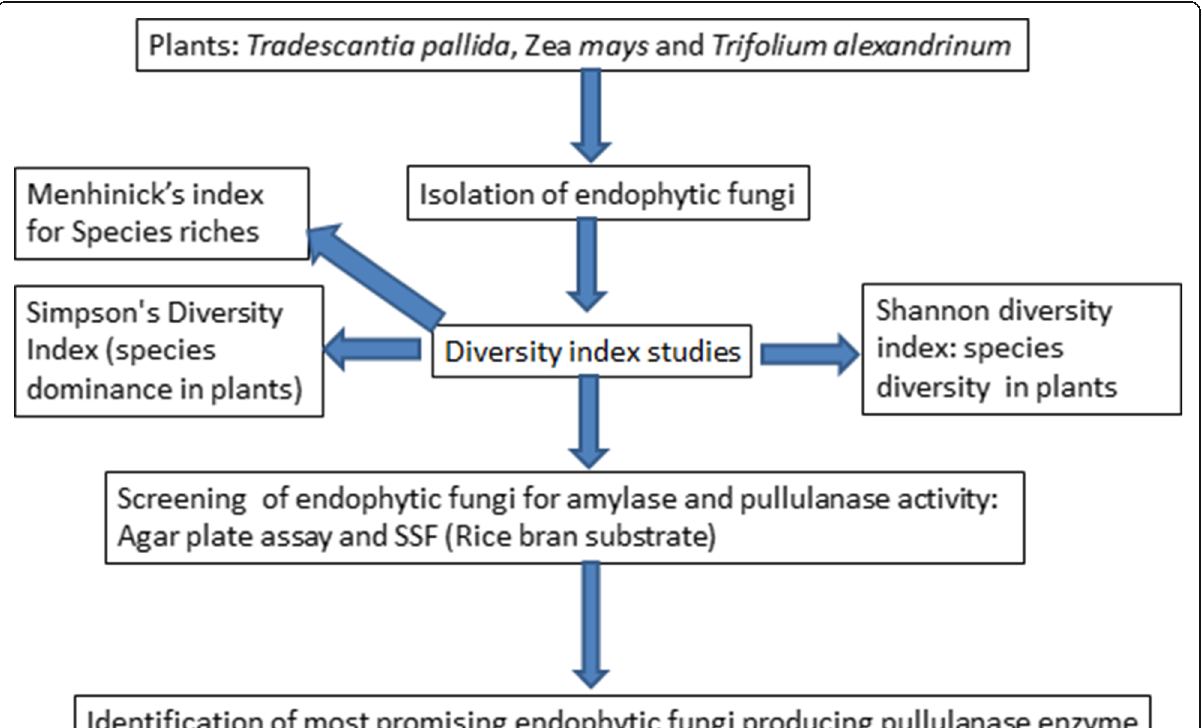
Fig. 1 The schematic representation of the present study